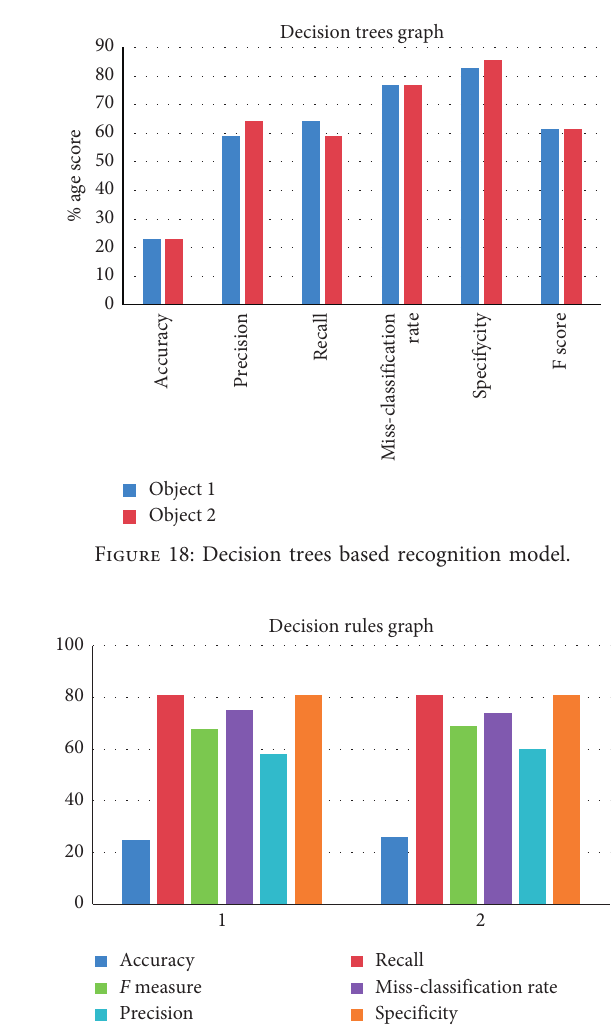
Figure 19: Decision rules recognition rates.